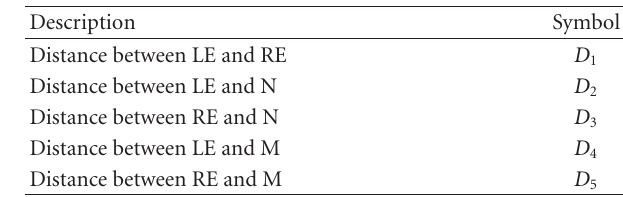
Table 1: Distance components of angle feature.